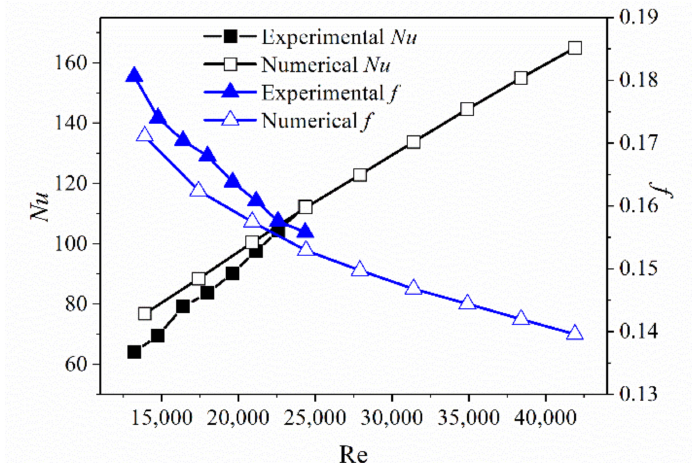
Figure 7. Simulation results and experimental results verification.